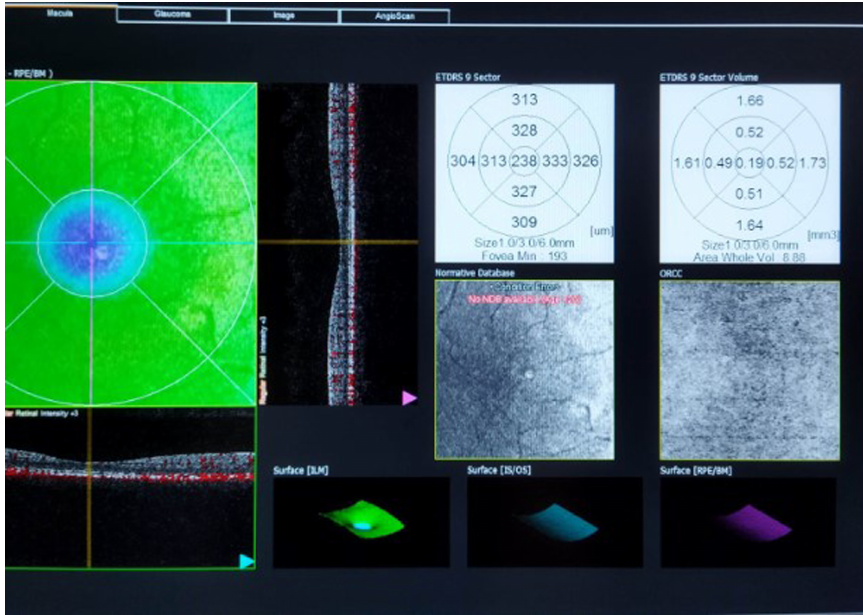
Figure 1. Measurement of the macular thickness according to the ETDRS chart using Nidek’s RS-3000 Advance and Navis Ex. Ver. 1.1.5 software. ETRDS, Early Treatment Diabetic Retinopathy Study.